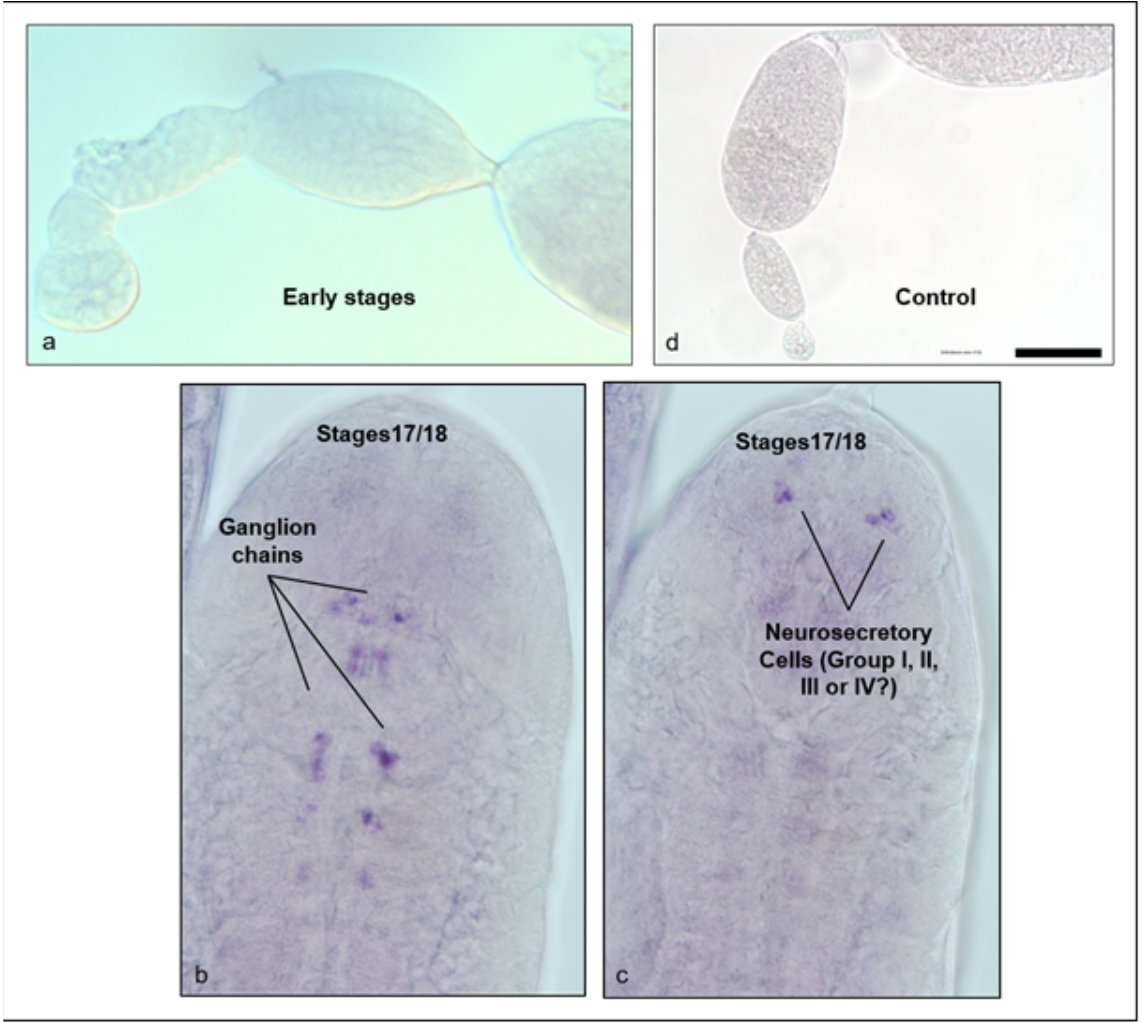
Figure 5 – In situ hybridization of ddc transcripts within virginoparae embryos. Ovaries were dissected from virginoparae morphs and hybridized with antisense (a, b and c) or sense (d)